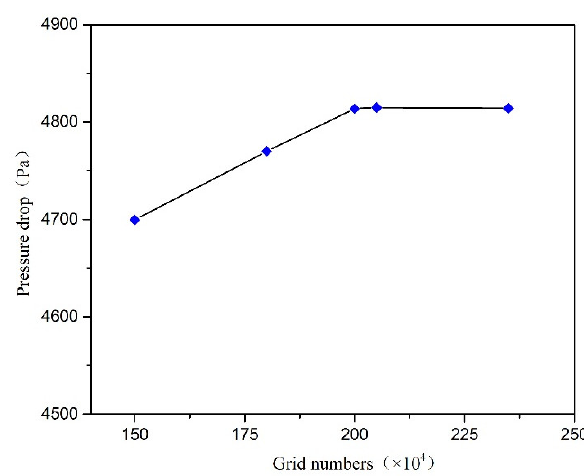
Figure 3. The calculation results in different grids.